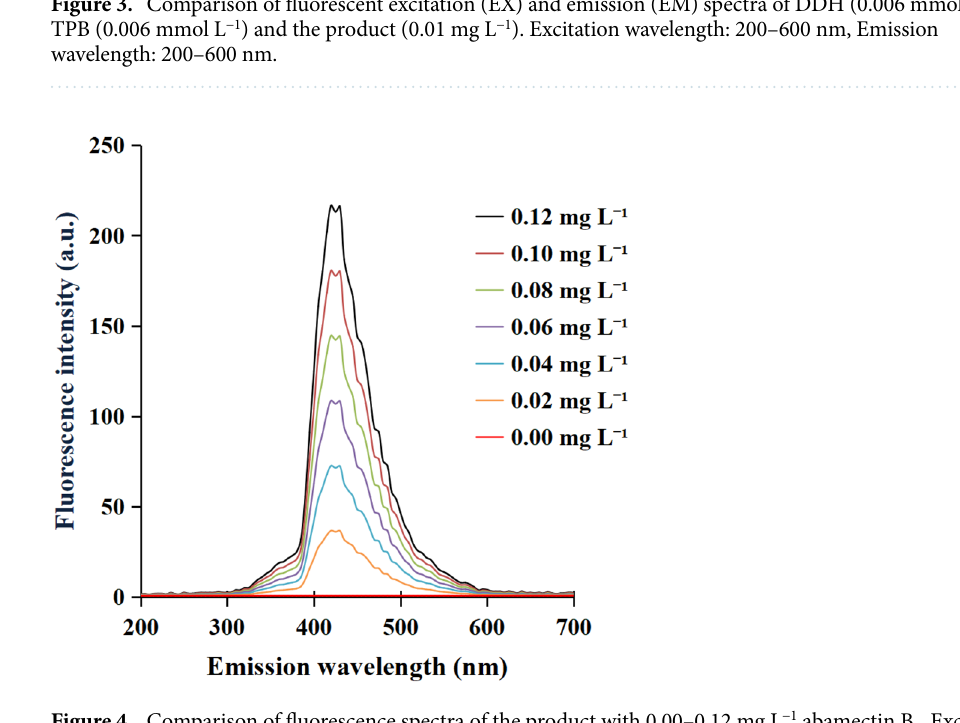
Figure 4. Comparison of fluorescence spectra of the product with 0.00–0.12 mg L −1 abamectin B 1 . Excitation wavelength: 360 nm, Emission wavelength: 200–700